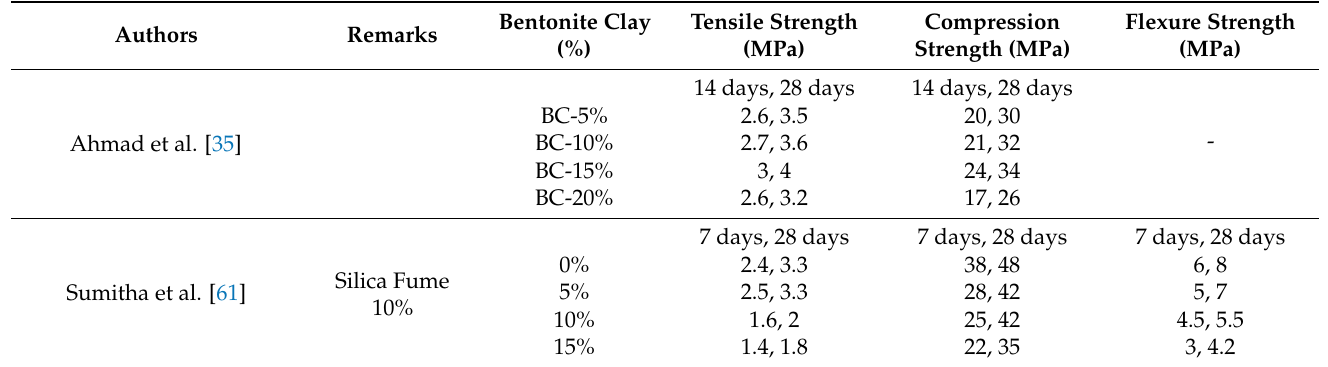
Table 4. Summary of mechanical performance of concrete with bentonite